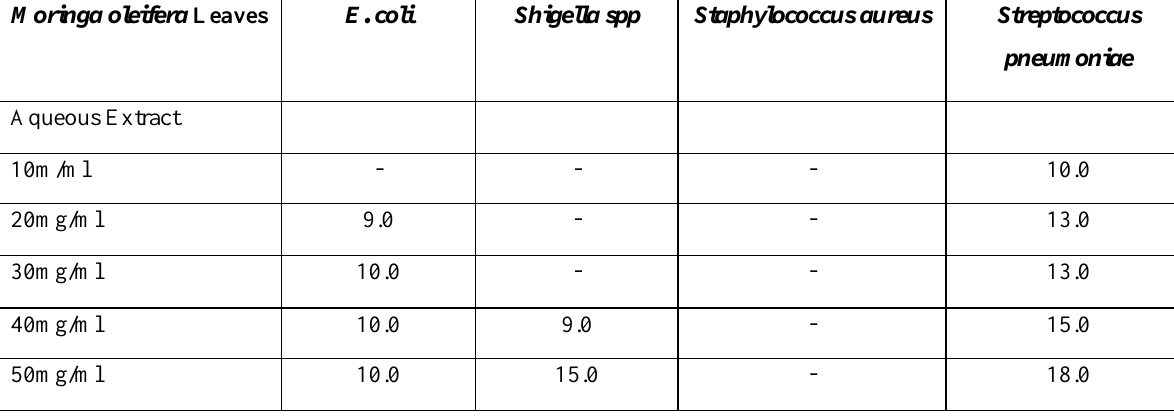
Table 5. Zone of Inhibition of aqueous extract of Moringa oleifera against the organisms.